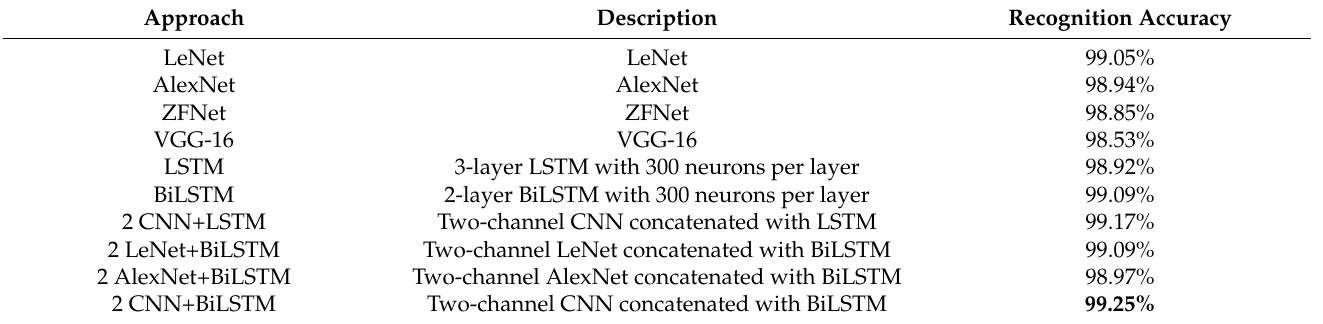
Table 7. Network performance of all the experiments conducted on the constructed HRRP dataset.